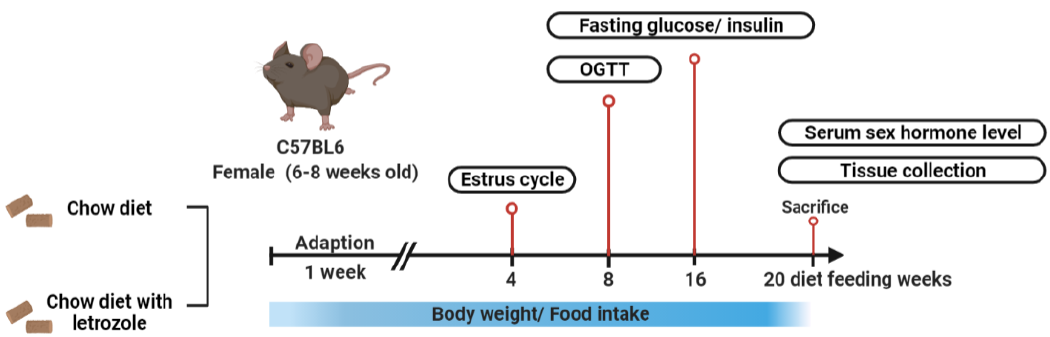
Figure 11. The procedure of the experiments.